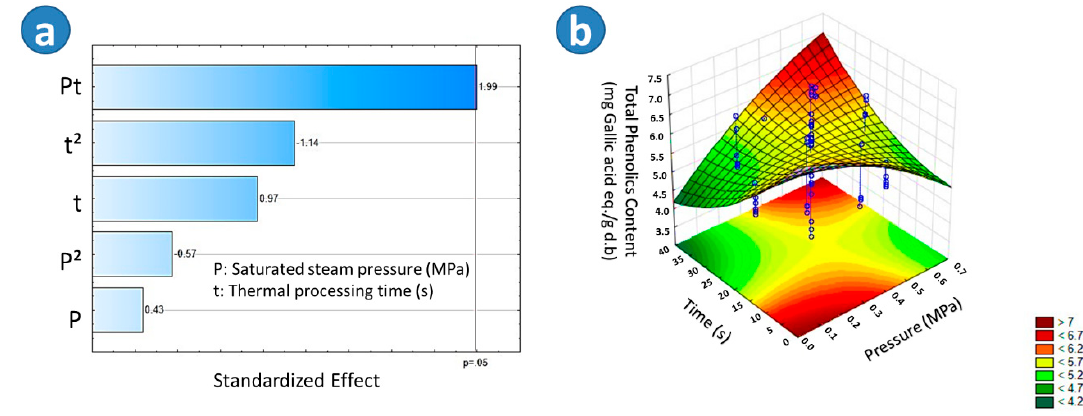
Figure 2. Effects of steam pressure “P” (MPa) and thermal processing time “t” (s) on the Total Phenol content (TPC) of Blanched Swell-Dried red beetroots (BSD). ( a ) The Pareto chart and ( b ) surface response plot are shown.